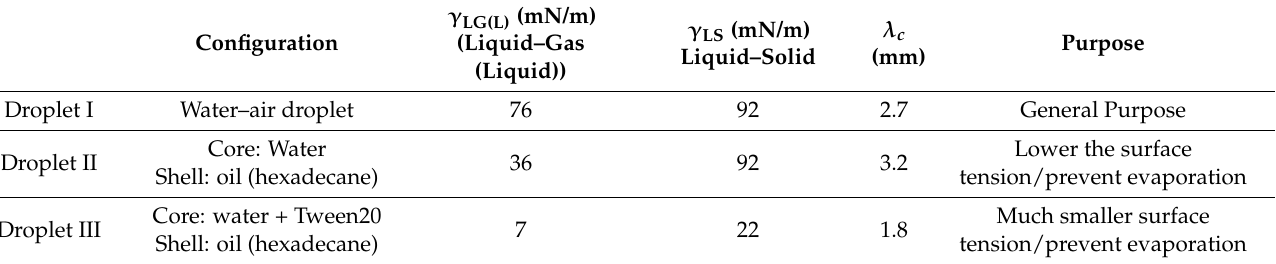
Table 1. Droplets used in this study (data from